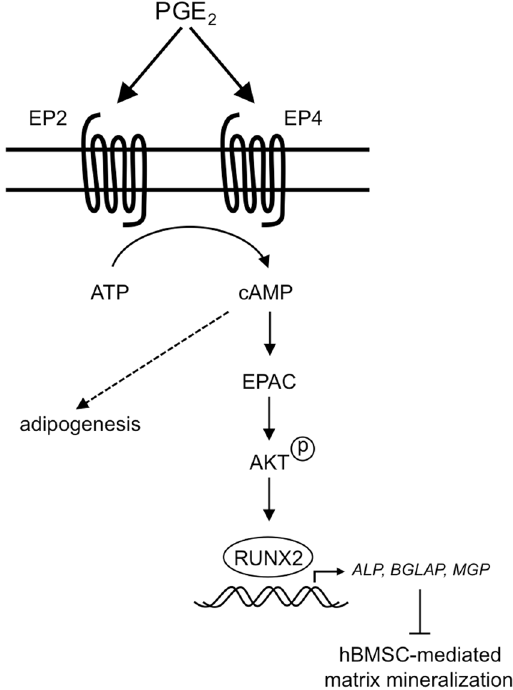
Figure 8. Proposed mechanism by which PGE 2 exerts its influence over hBMSC-mediated matrix mineralization. Based on the findings presented in the current report, we propose that PGE 2 increases intracellular cAMP levels via receptors EP2 and EP4, leading to activation of Epac, which in turn acts to sustain AKT phosphorylation levels. Prolonged AKT activation ultimately results in impaired hBMSC-derived osteoblast maturation and matrix mineralization, possibly by inducing temporal changes in the production and activity of RUNX2 and its downstream target genes (e.g. ALP , BGLAP and MGP ). The signaling pathways responsible for mediating the stimulatory effects of PGE 2 on hBMSC adipogenesis still remain to be